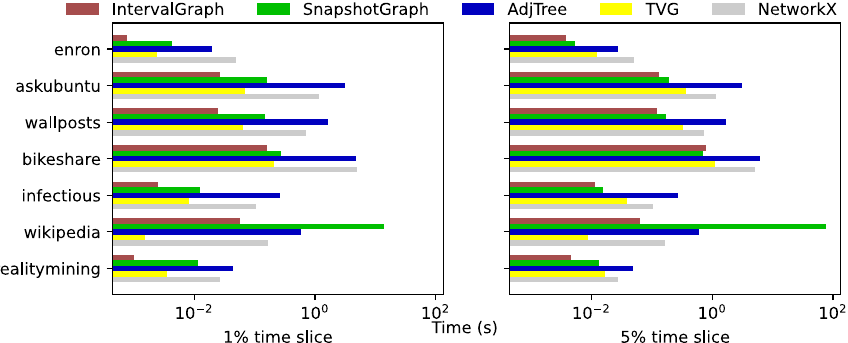
Fig. 2 Time-based slice times for 1% and 5% time slices across all data sets. The proposed hybrid interval tree structure has significantly lower slice times on most data sets